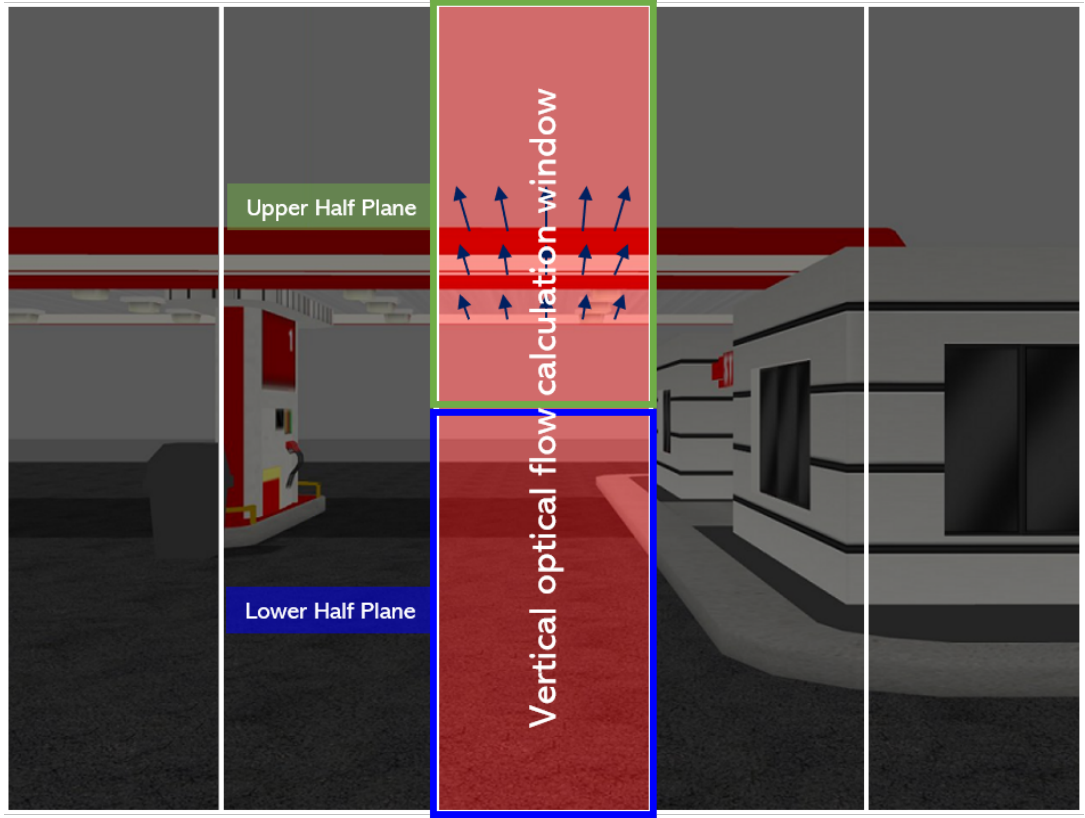
Figure 4. Vertical optical flow calculation